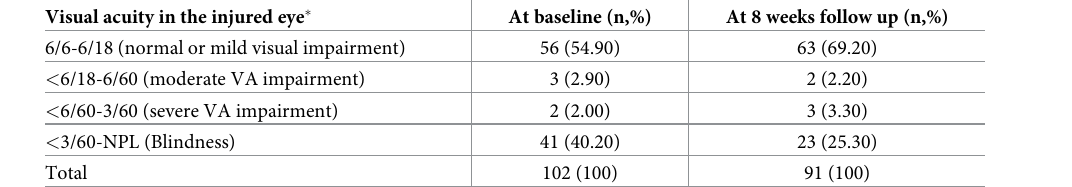
Table 4. Visual Outcome of ocular trauma. Visual acuity in the injured eye � At baseline (n,%) At 8 weeks follow up (n,%) 6/6-6/18 (normal or mild visual impairment) 56 (54.90) < 6/18-6/60 (moderate VA impairment)